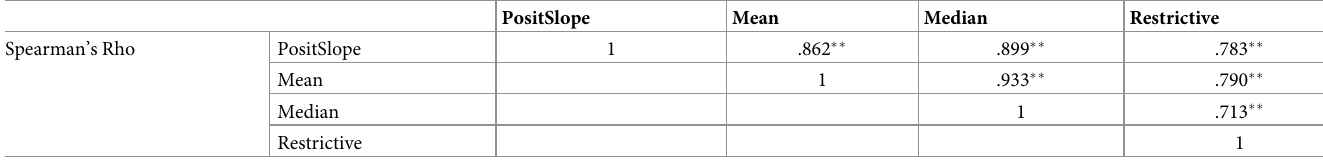
Table 4. Spearman’s Rho